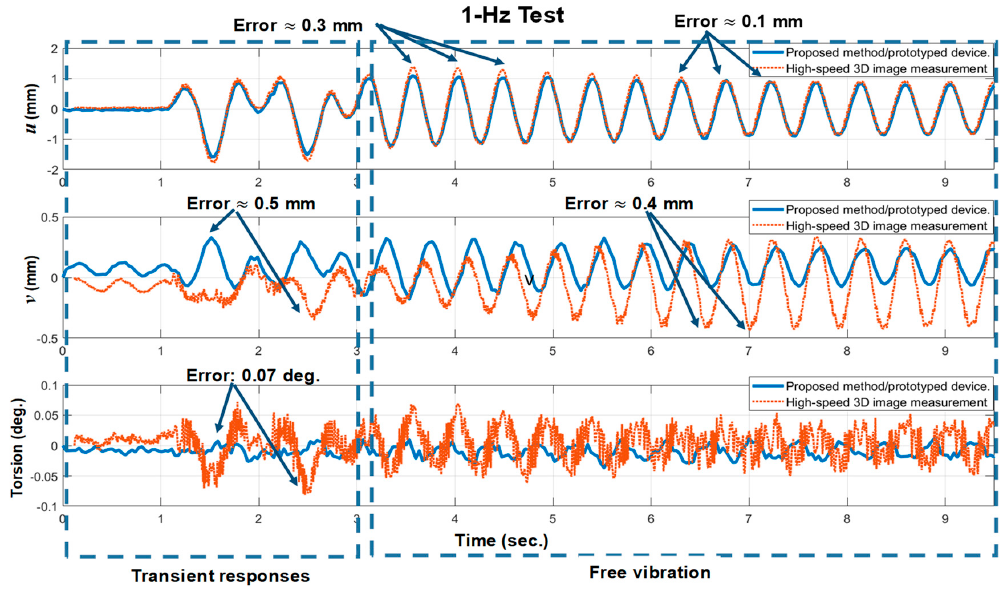
Figure 7. Inter-story responses for the 1-Hz test.